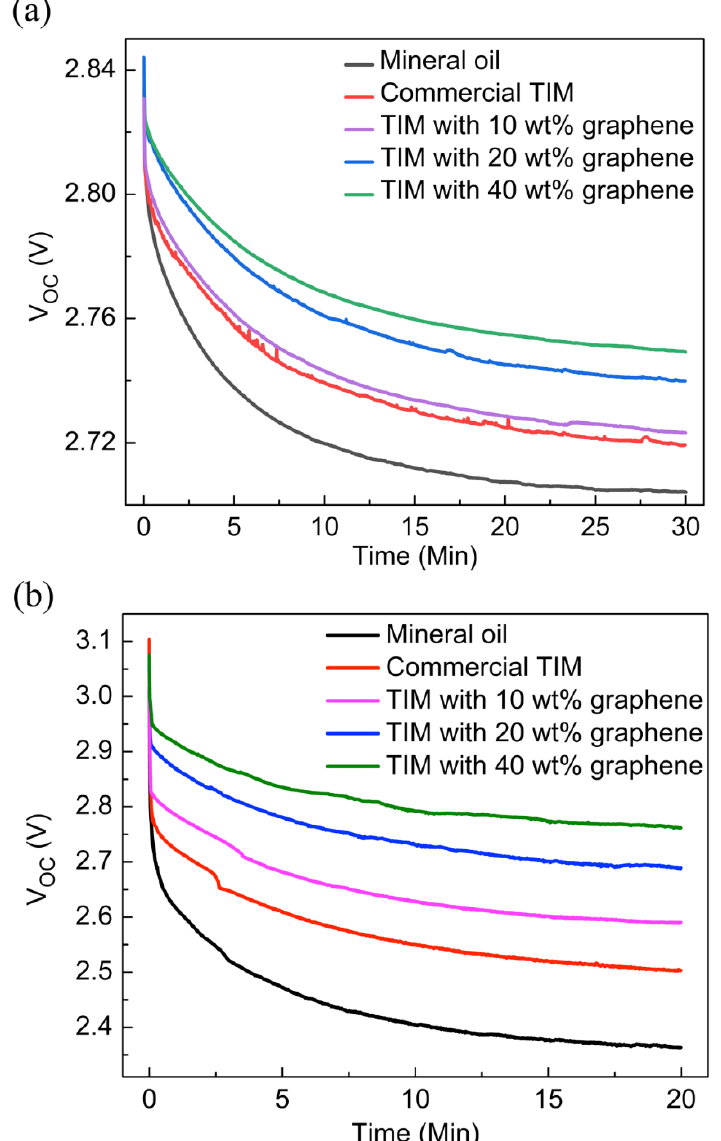
Figure 3. ( a ) Open-circuit voltage of a solar cell as a function of time under constant illumination of 70× suns. ( b ) Open-circuit voltage of a solar cell as a function of time under constant illumination of 200× suns. The data are presented for TIMs with different loading of graphene as well as for reference mineral oil and commercial TIM (Ice Fusion). The TIM with 40 wt% graphene demonstrates the least reduction in V OC due to better heat dissipation and, correspondingly, lower temperature of the solar cell.